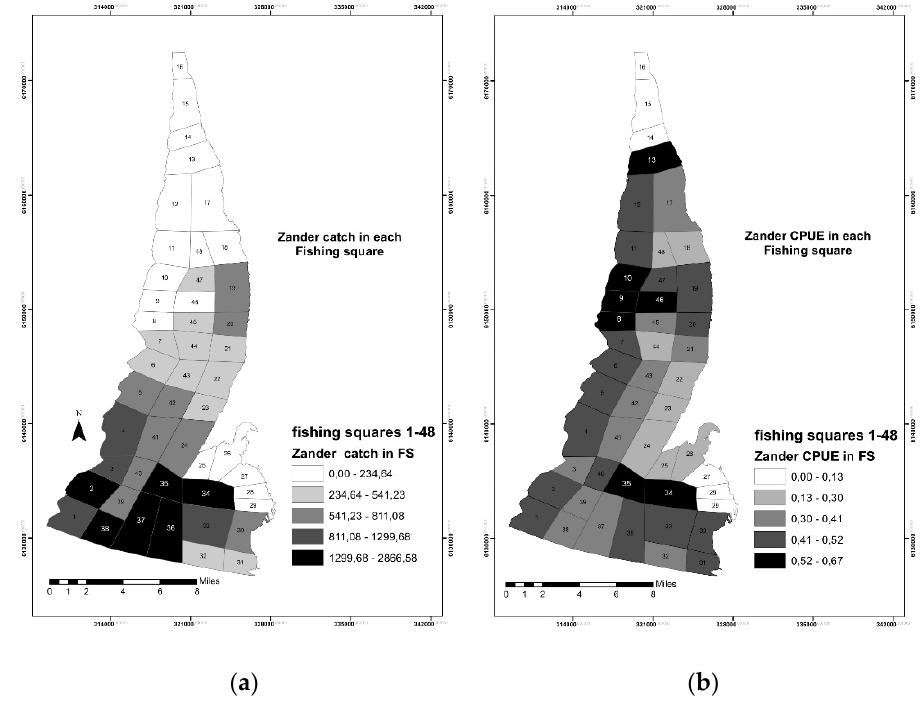
Figure 3. Distribution of zander catches of commercial fisheries in fishing square: ( a ) total catch in each fishing square in kilograms, ( b ) CPUE of zander by the 40–80 mm mesh size gillnets.